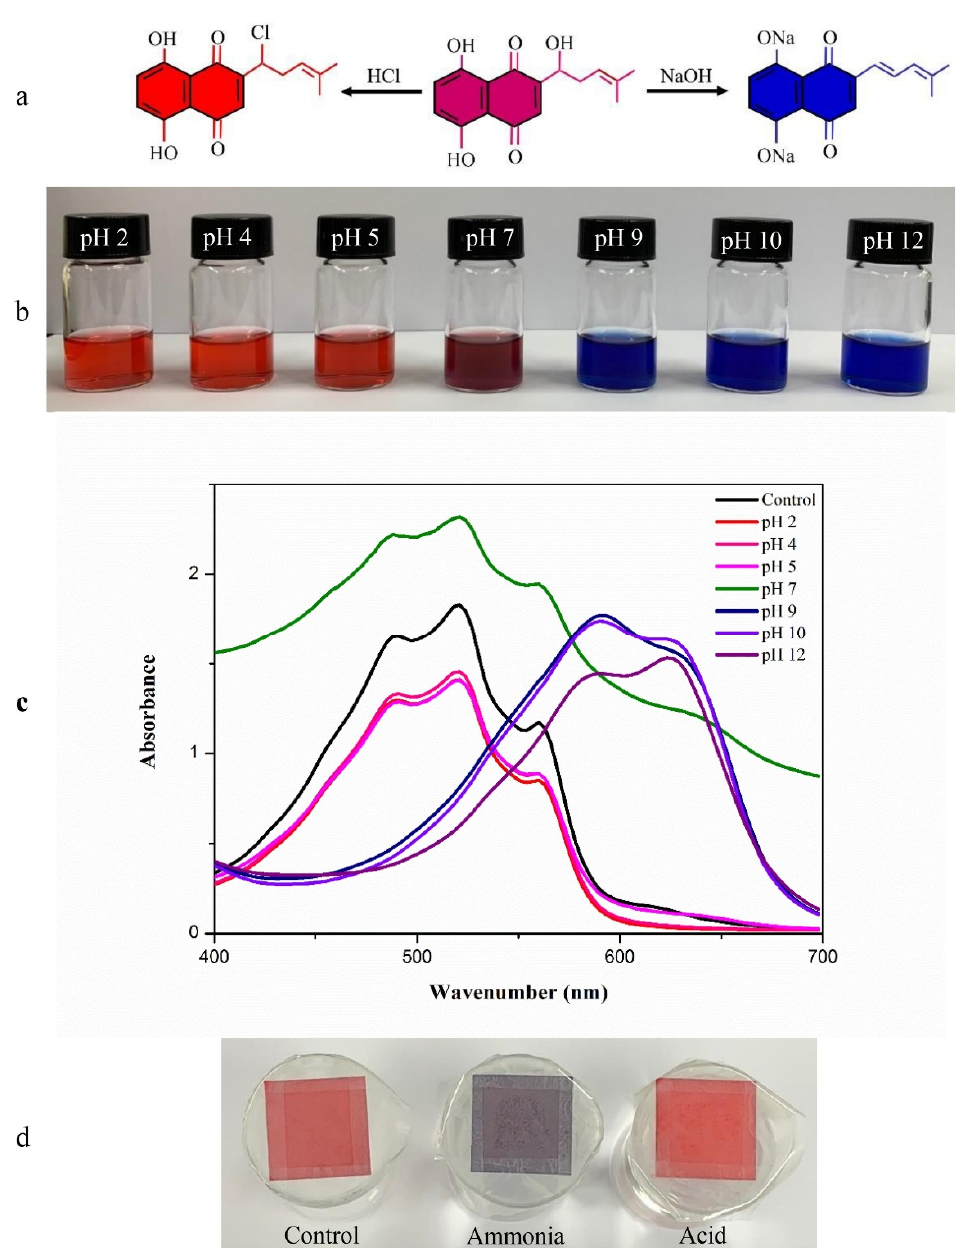
Figure 2. ( a ) The reaction of shikonin at acid-base conditions ( b ) color of shikonin solution at various pH levels, ( c ) UV–vis spectra of shikonin solution at various pH levels, and ( d ) response of the color indicator paper to ammonia and acetic acid vapors (taken from [7]).